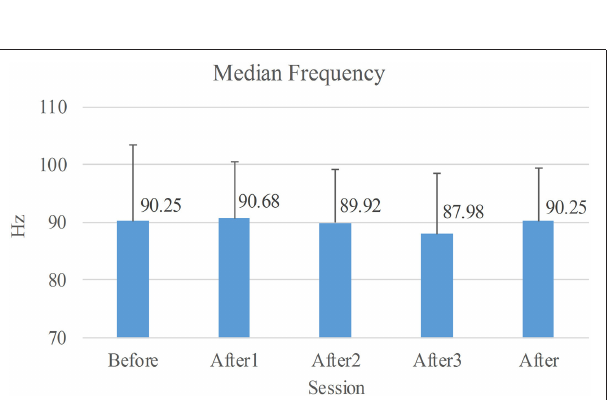
FIGURE 5 | CoG f for EEG-EMG coherence. Avg. indicates average.